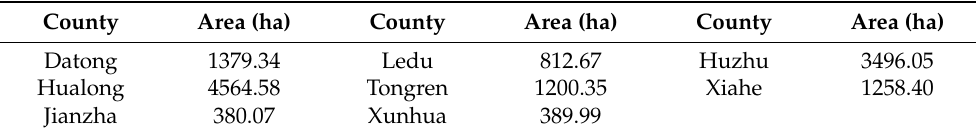
Table A1. CGEQ/HFD.